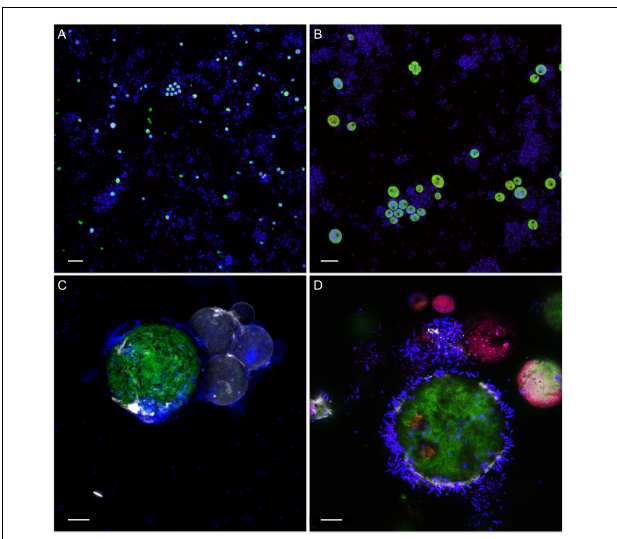
FIGURE 3 | Confocal laser scanning micrographs of algae-bacteria cultures. The micrographs show different algae ( A: C. vulgaris G1-G; B: S. vacuolatus G1-O; C,D : H. lacustris G1-R) that were inoculated with M. goesingense Vab1 with an initial optical density of 0.5 and visualized after 7 days of incubation. The microbial communities were stained with the LIVE/DEAD bacterial viability kit (Thermo Fisher Scientific, MA, United States) that allows differentiating between living and dead cells in combination with calcofluor white (0.15%) to enhance fluorescence of the algae. Green: autofluorescence of algae; blue: living cells; red: dead cells. Scale bar: 10 µ